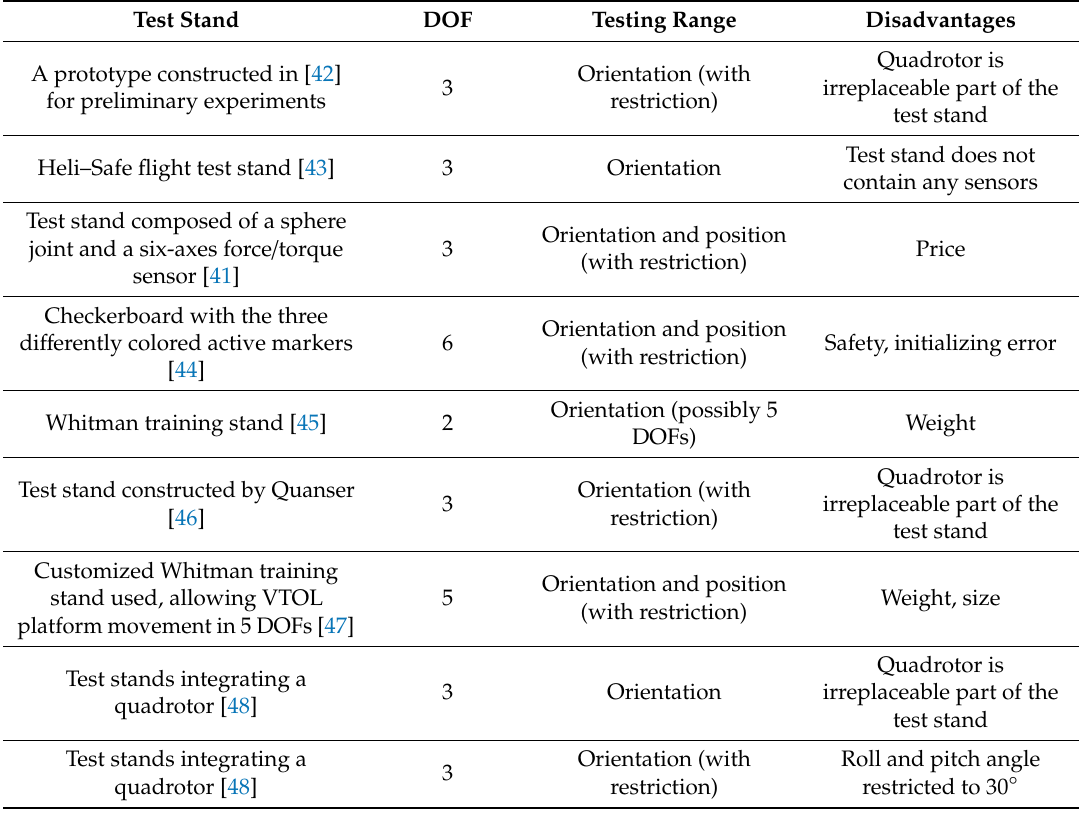
Table 1. Usage, disadvantages and possible degrees of freedom (DOF) of analyzed test stands.